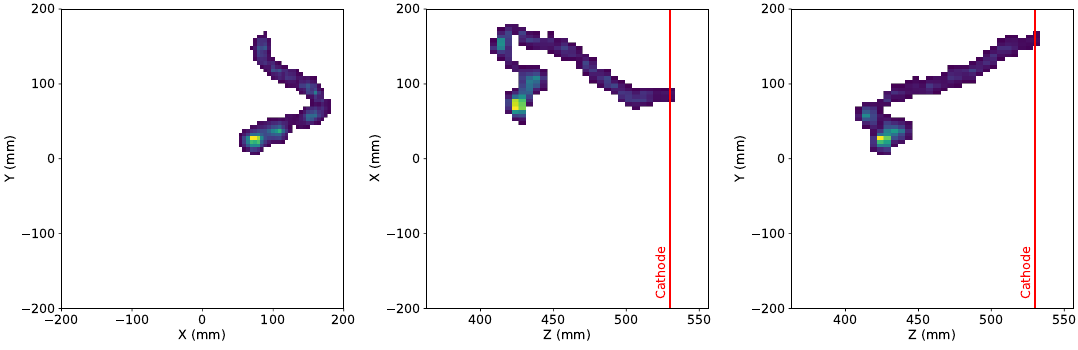
Figure 8 . High energy ( E > 1 : 5 MeV) electron originating from the cathode. The three projections, XY (left), ZX (center) and ZY (right), show the expected topological signature of an